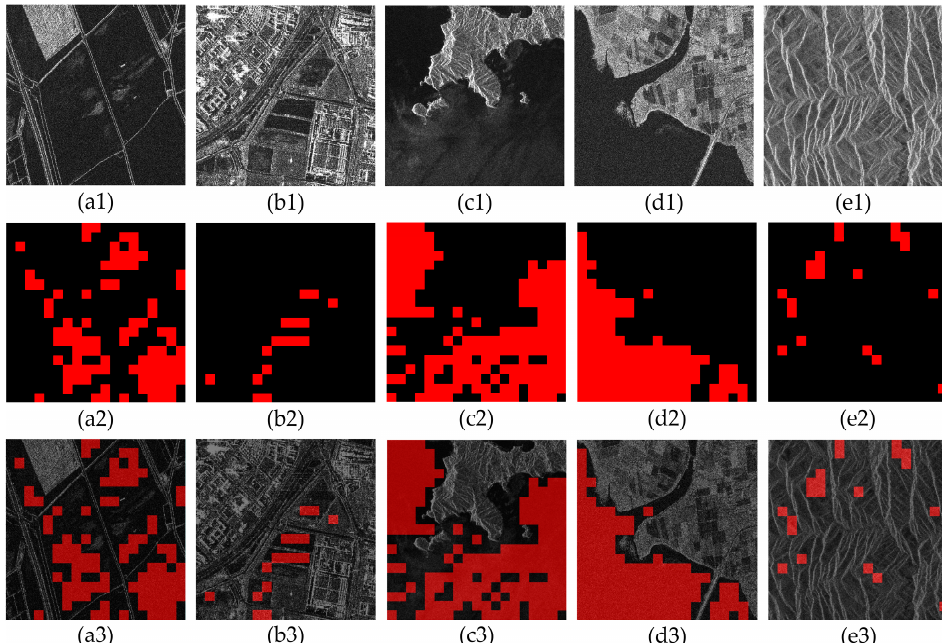
Figure 3. ( a1 ) GF-3, ( b1 ) TerraSAR-X, ( c1 ) Sentinel-1, ( d1 ) RadarSAT-2, ( e1 ) ALOS-2. ( a2 – e2 ) are the homogeneous region images automatically selected using ( a1 – e1 ). ( a3 – e3 ) are the composite images of the original images and the homogeneous region images. Table 2. Quantity and accuracy of selected homogeneous regions.